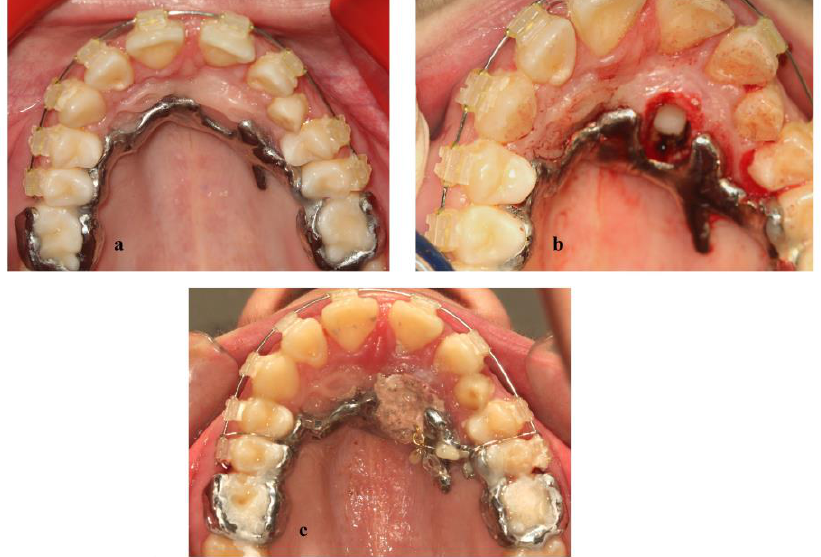
Figure 5. ( a ): The device fitted on the patient’s mouth, ( b ): surgical exposure of the canine, ( c ): gold chain bonded on the canine’s crown and surgical pack protecting the surgical site (patient 1).